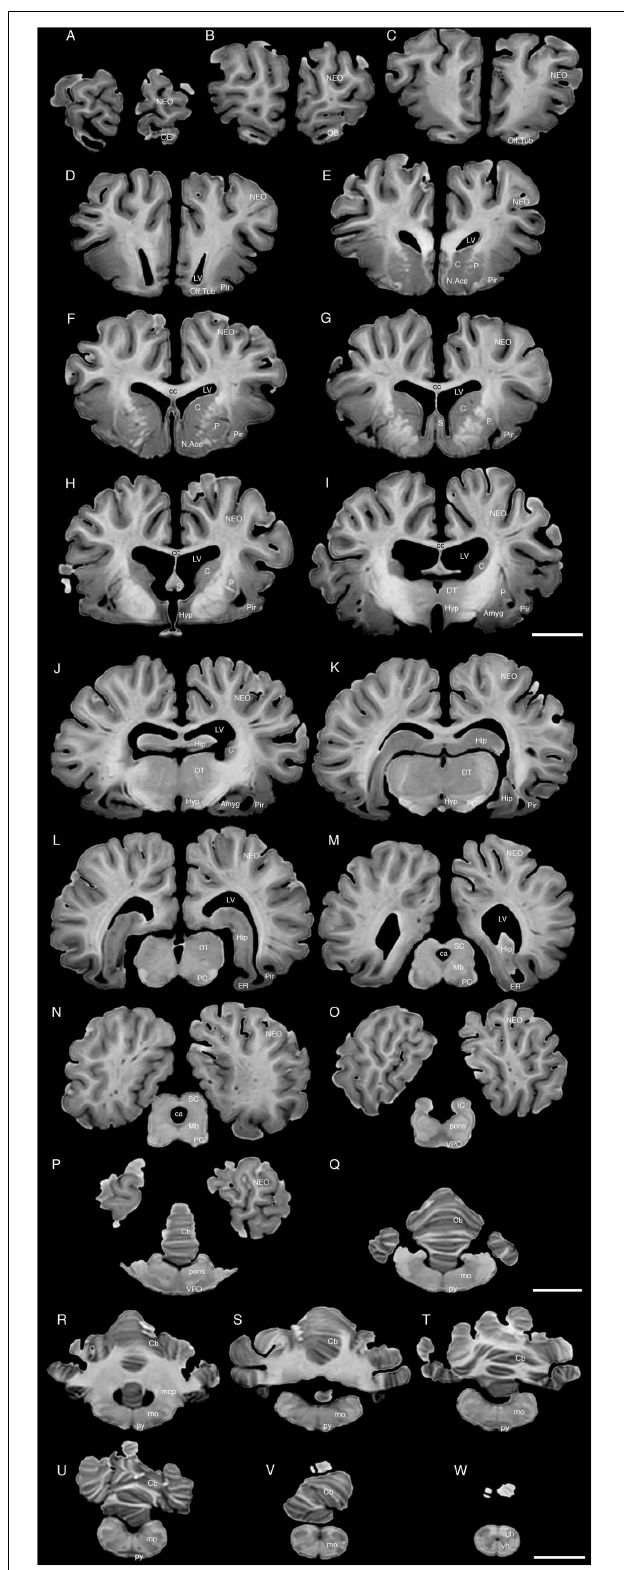
FIGURE 4 | A series of coronal structural MR images through the brain of the white rhinoceros ( C. simum ). (A) is the most rostral section and (W) is the most caudal section, with each section having a thickness of 2 mm and each section being 6 mm apart. Note the typically mammalian topography of the various regions and structures of the brain. Scale bar = 2 cm. Amyg, amygdaloid body; C, caudate nucleus; ca, cerebral aqueduct; Cb, cerebellum; cc, corpus callosum; dh, dorsal horn; DT, dorsal thalamus; EC, entorhinal cortex; Hip, hippocampus; Hyp, hypothalamus; IC, inferior colliculus; LV, lateral ventricle; N.Acc, nucleus accumbens; NEO, neocortex; Mb, midbrain; mcp, middle cerebellar peduncle; mo, medulla oblongata; OB, olfactory bulb; Olf. Tub, olfactory tubercle; P, putamen; PC, cerebral peduncle; Pir, piriform cortex; py, pyramidal tract; S, septal nuclear complex; SC, superior colliculus; vh, ventral horn; VPO, ventral pontine